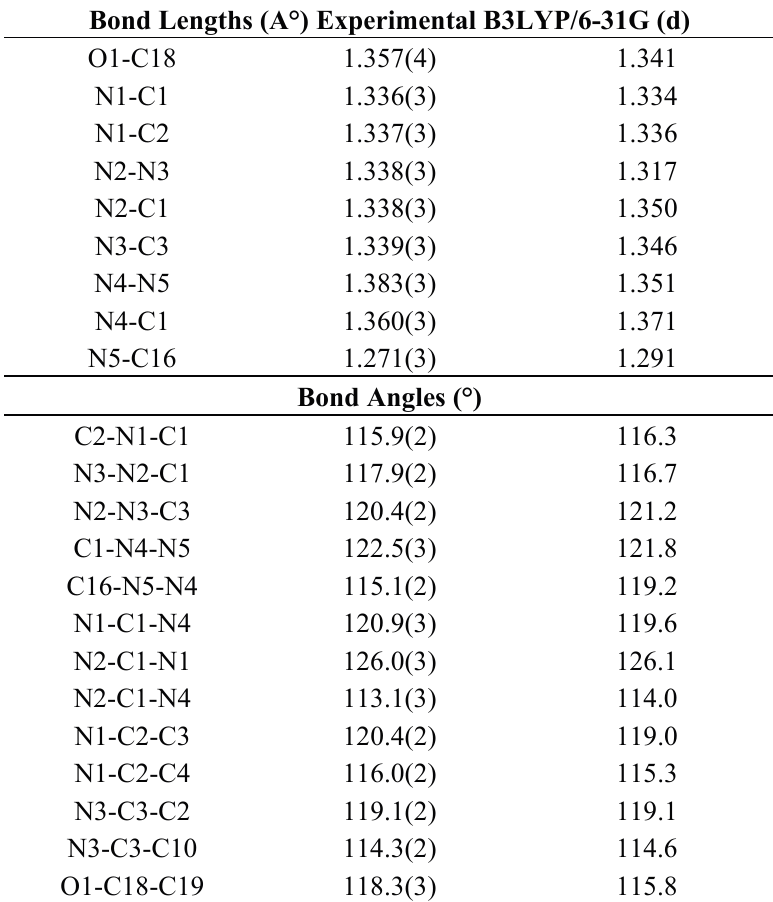
Table 6. Selected molecular structure parameters of compound 4